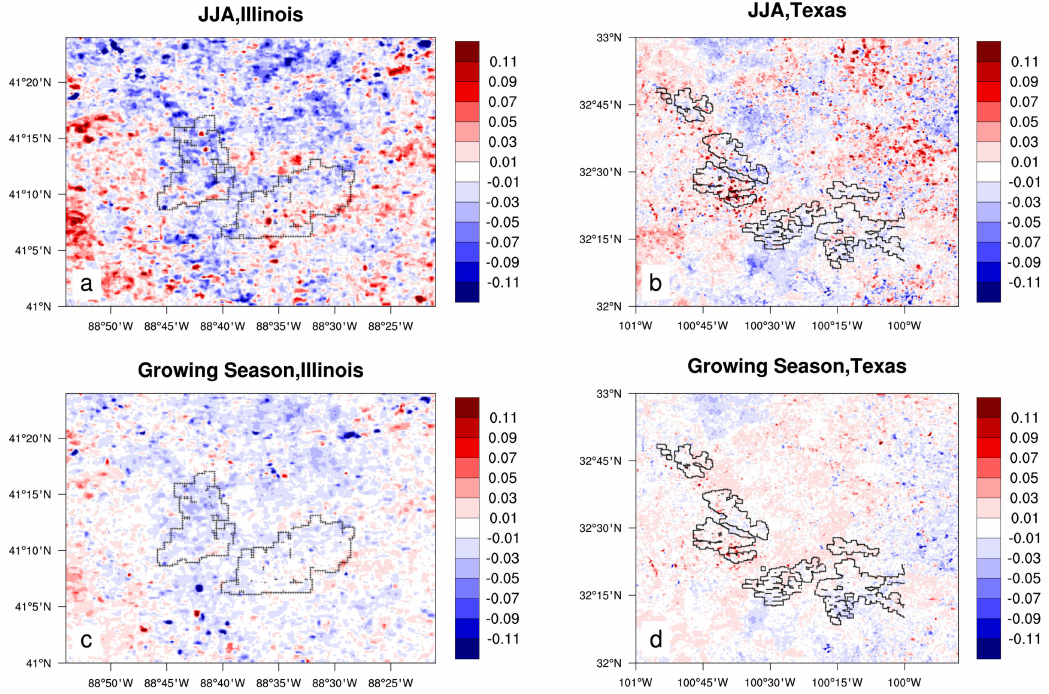
Figure 5. Spatial patterns of DEVI (2010-2014 averages minus 2003–2004 averages) during JJA and the growing season: ( a ) JJA in Illinois, ( b ) JJA in Texas, ( c ) the growing season in Illinois, ( d ) the growing season in Texas. The black dots indicate the boundary of WFPs. Table 1. Areal mean DEVI for WFPs and NWFPs during JJA and the growing season (in parenthesis) in Illinois and